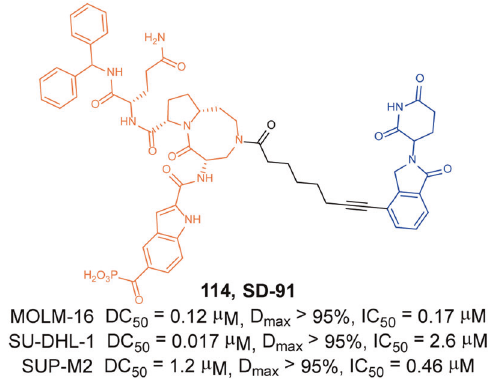
Fig. 26 The representative PROTAC targeting STAT3